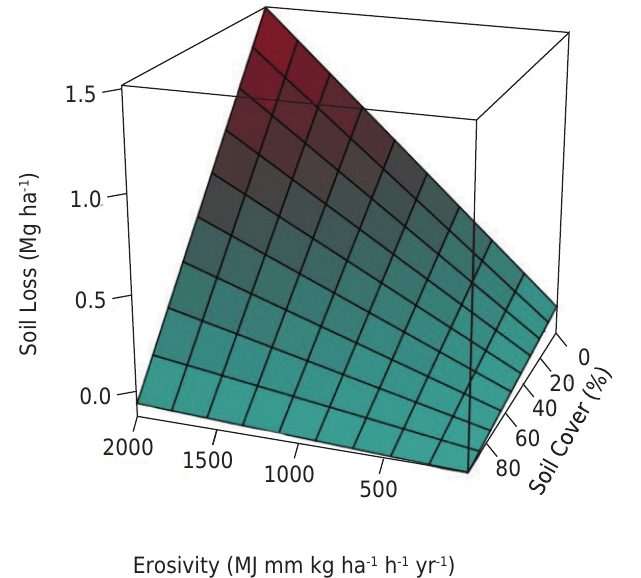
Figure 2. Interaction between erosivity and the soil cover index variable using linear mixed models to predict soil loss in a Typic Hapludox in Lavras, MG, Brazil